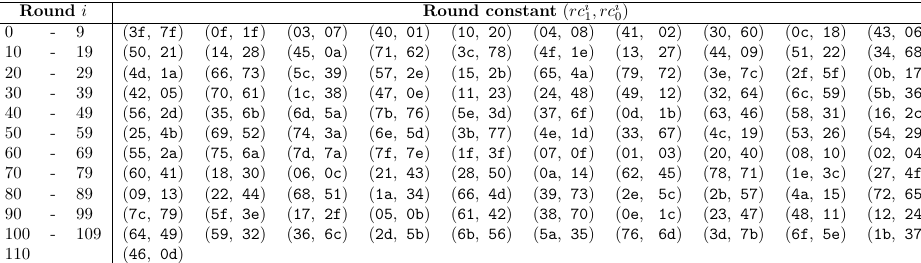
Table 12: Round constants of the WAGE